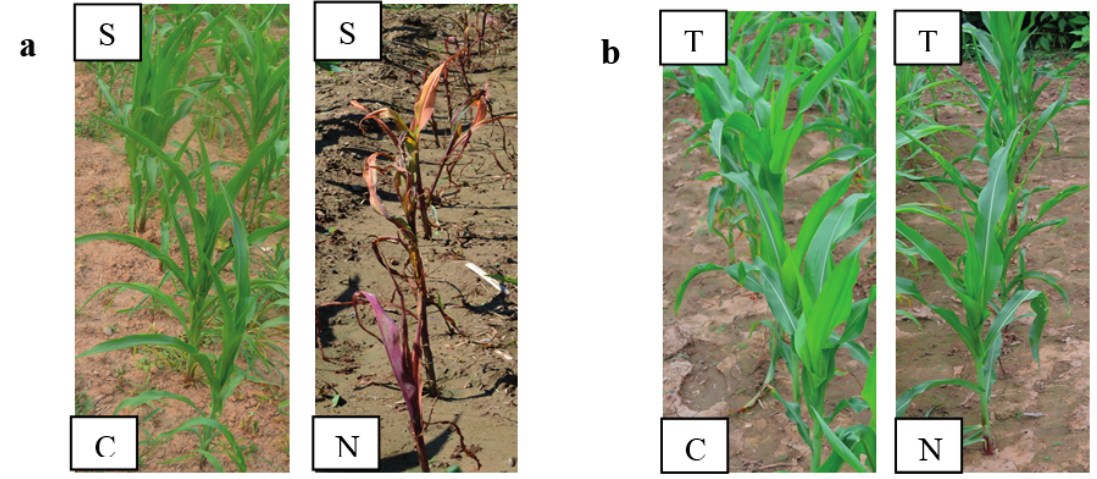
Figure 1. Field response test of susceptible and tolerant maize plants after application of 60 g ai ha − 1 nicosulfuron. The photos were taken 14 days after nicosulfuron treatment. Response of untreated and nicosulfuron-treated susceptible maize plants ( a ); Response of untreated and nicosulfuron-treated tolerant maize plants ( b ). S: Nicosulfuron-susceptible maize; T: Nicosulfuron-tolerant maize; C: control